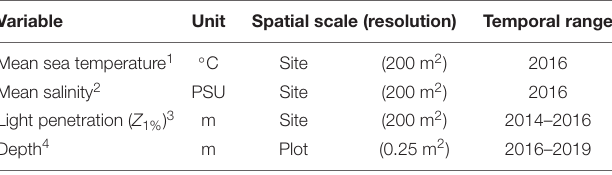
TABLE 2 | Environmental factors used in multivariate variance-partitioning analyses on community composition.